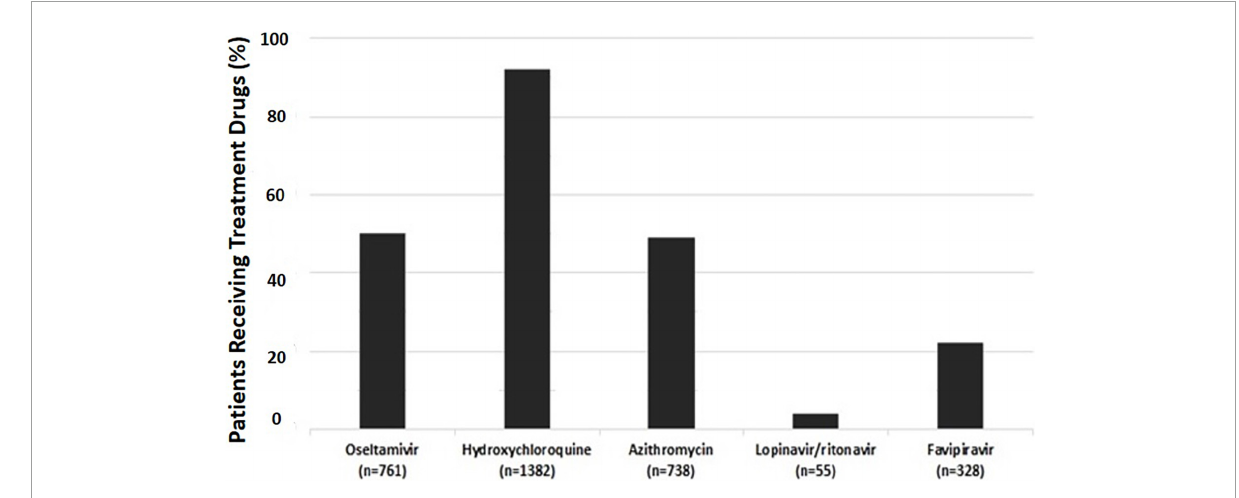
FIGURE3 Frequency of the patients, who were administered any of the given drugs; either alone or in combination with other drugs.